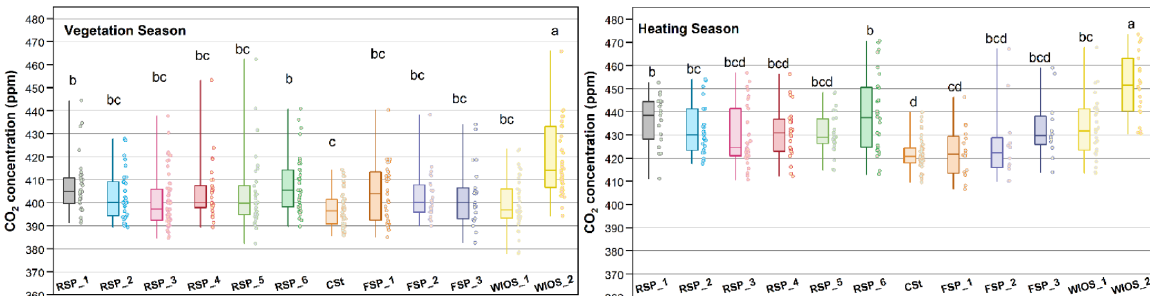
Figure 4. Box plot of the measured atmospheric CO 2 concentration in the sampling sites over the study period (vegetation vs. heating) in July 2017–August 2018. The box components indicate the median (horizontal line) and range between the 25th and 75th percentile of the measured values, respectively. The whiskers represent the highest and lowest 1.5 × IQR (interquartile range) of the mean data values. The various lower-case letters show which measurements for individual sampling points by comparing seasonal CO 2 trends were significantly different. The marks “RSP_1-6” indicate rooftop- level measurement sites, “FSP_1-3” soil flux sampling places, “CSt” means a location with continuous diurnal series measurements (“Cybulskiego station”), WIOS_1-2 are respectively measurement stations operated by the Inspectorate of Environmental